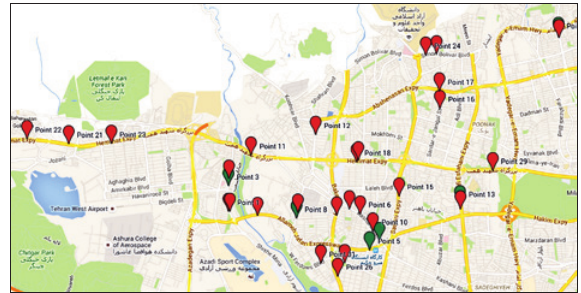
Figure 1. Location of selected measurement points on map